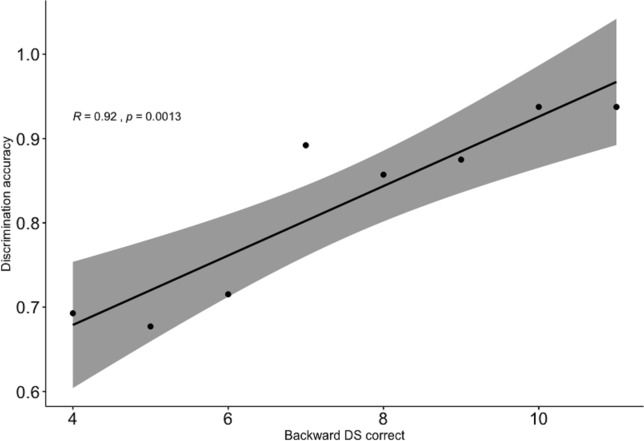
Correlation between discrimination accuracy and backward digit span task (aggregated participant results).Confidence interval is shown in grey.